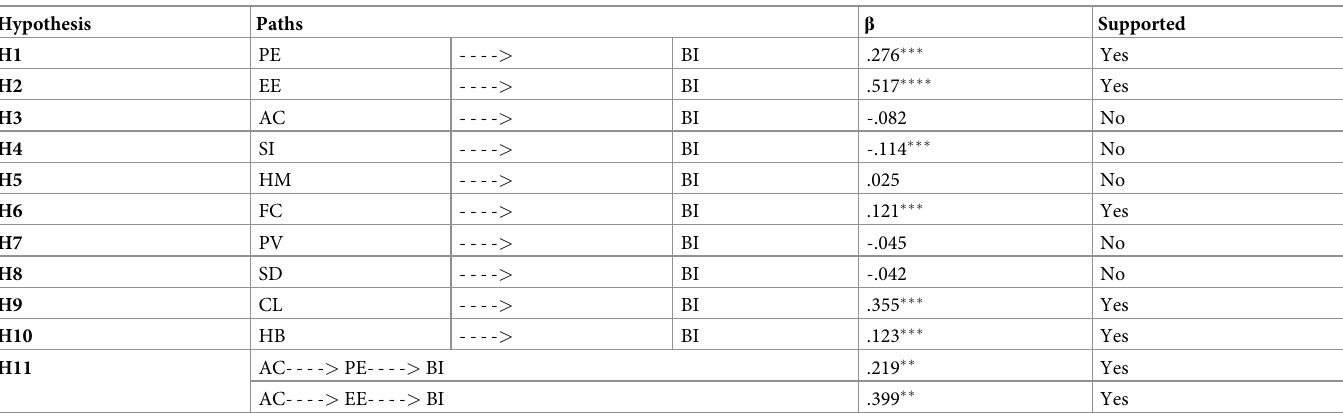
��� significant at 0.01